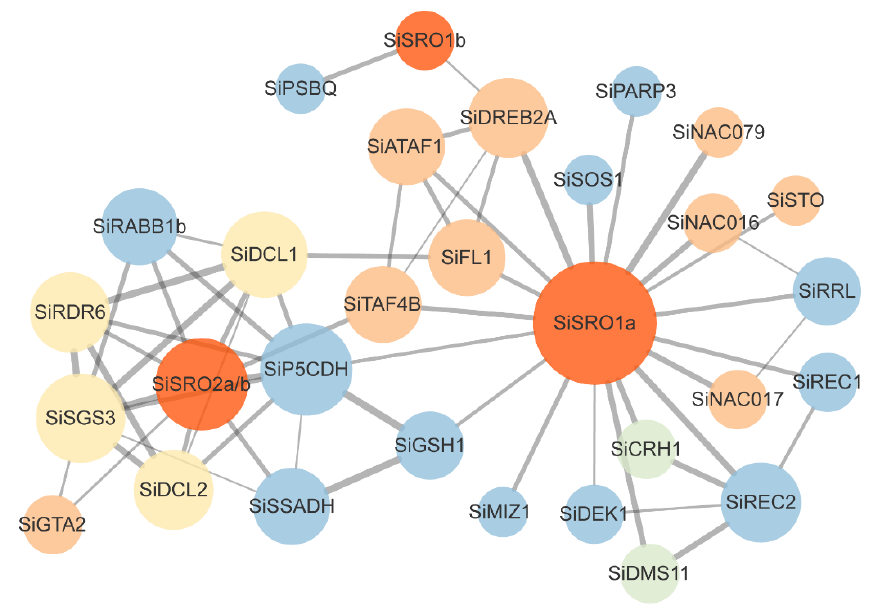
Figure 8. Protein interaction network analyses of SiSROs. Interaction networks were constructed based on homology of SiSROs in Erythranthe guttata using STRING database (https://string-db.org/, accessed on 11 October 2021). The sesame homologs of the SROs-interaction proteins in E. guttata were identified with reciprocal best BLASTP analysis and shown in network diagrams. Size of node indicates its connectivity degree, and the thickness/redness of the line represents the interaction score. Different colors represented different functional categories. The gene annotation of interaction proteins is available in Table S4.